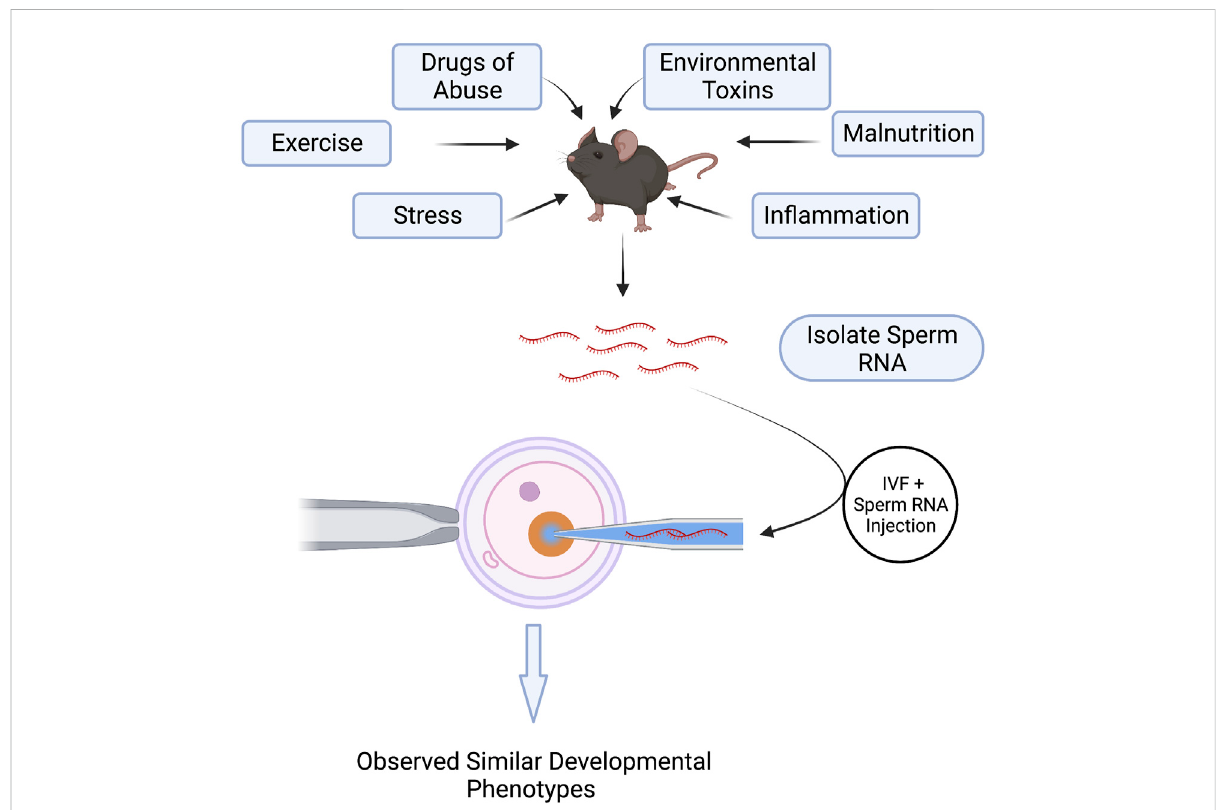
FIGURE 4 Injection of Sperm noncoding RNAs Recapitulate Environmentally-Induced, Paternally-Inherited Phenotypes in Offspring. Environmental exposures and paternal stressors alter the repertoire of noncoding RNAs carried in sperm. Isolation of these noncoding RNAs from exposed sperm and injection into naïve, in vitro -produced embryos induces similar growth and metabolic phenotypes in the offspring as those emerging from in vivo -derived embryos. These experiments demonstrate a causal role of sperm noncoding RNAs in the paternal transmission of environmentally-induced